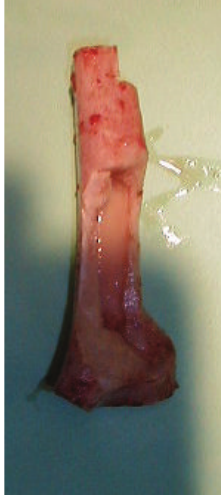
Figure 3: The irradiated bone segment.